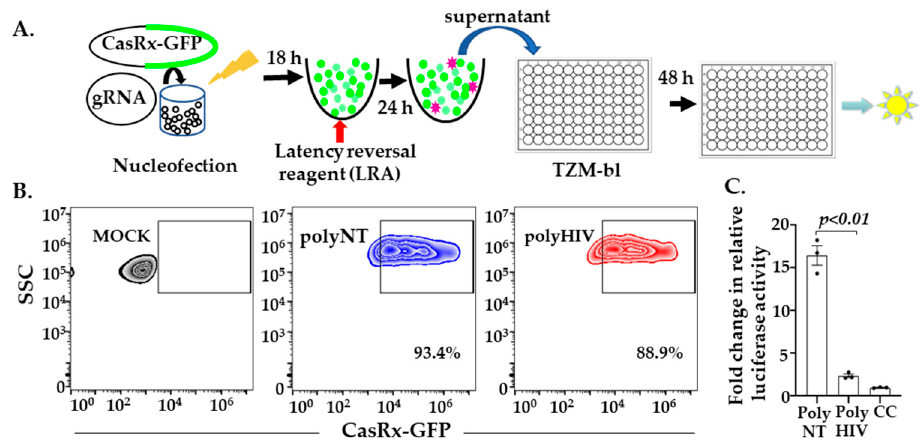
Figure 5. CasRx-silencing reduces HIV-1 expression from latent provirus ( A ) We nucleofected J1.1 cells with plasmids encoding gRNAs and CasRx-GFP and stimulated them with a latency reversal reagent (LRA; PMA), collected the supernatants 24 h post-stimulation and added these supernatants to the TZM-bl cells. Relative luciferase expression was measured after 48 h and presented as a fold change in relative luciferase activity normalized to the cells only control (CC); ( B ) GFP expression by >80% of J1.1 cells indicated successful transfection with CasRx-GFP and gRNA plasmids; ( C ) Supernatants from cells transfected with gRNAs targeting HIV (polyHIV) vs. non-targeting (polyNT) showed significantly reduced luciferase activity. The means ± s.e.m. are depicted as horizontal and vertical bars for each group, respectively. The Student’s t -test was used for statistical comparisons, and two-tailed p values are